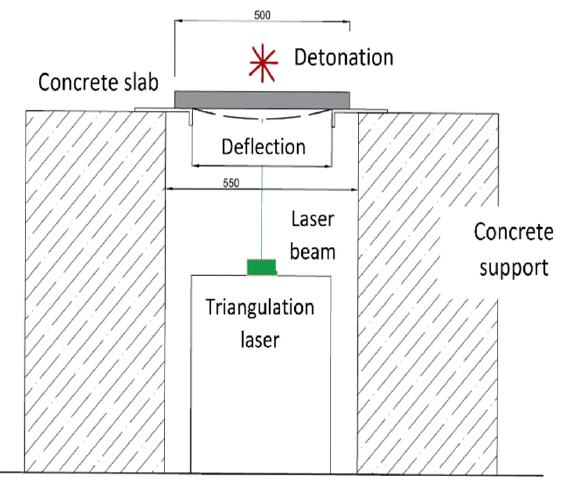
Figure 3. Experimental setup [52].